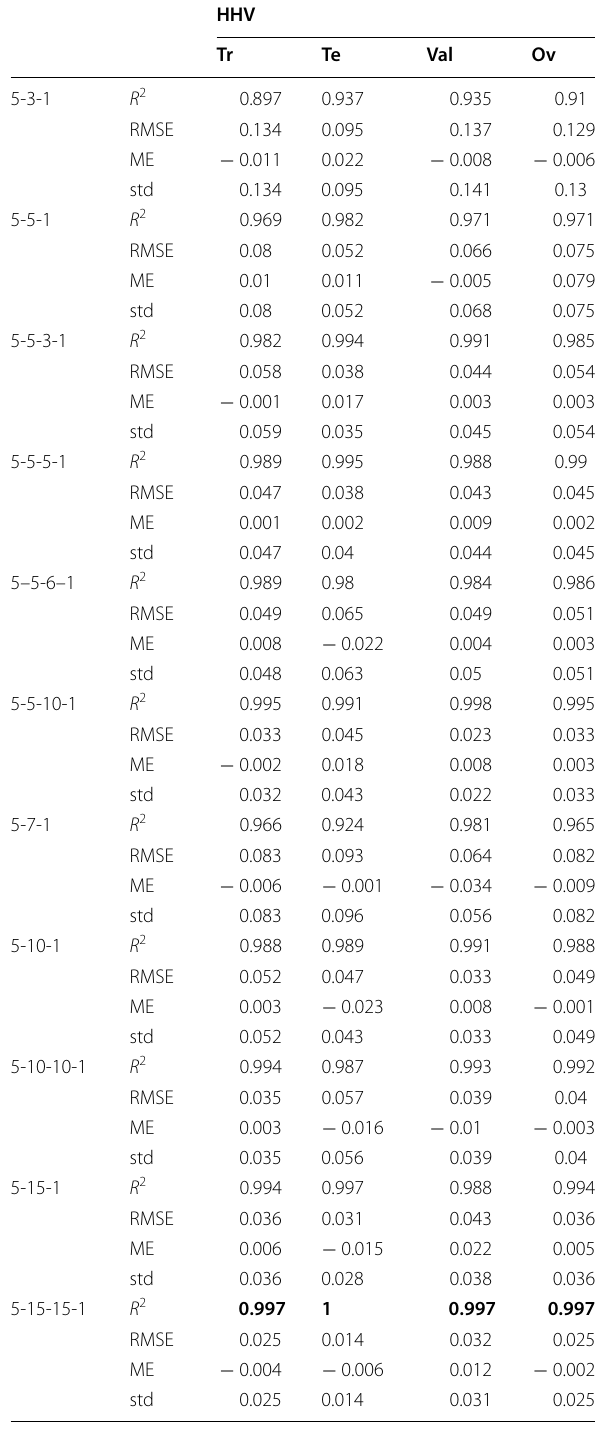
Table 4 Selection of the optimum MISO-ANN network for